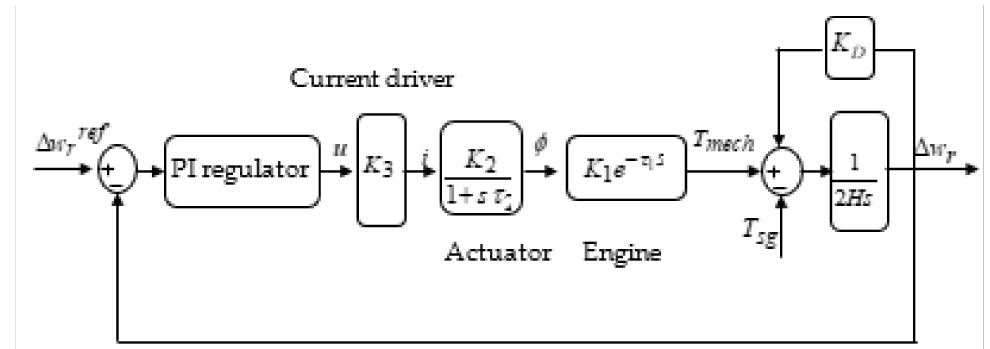
Figure 2. Diagram of the diesel engine